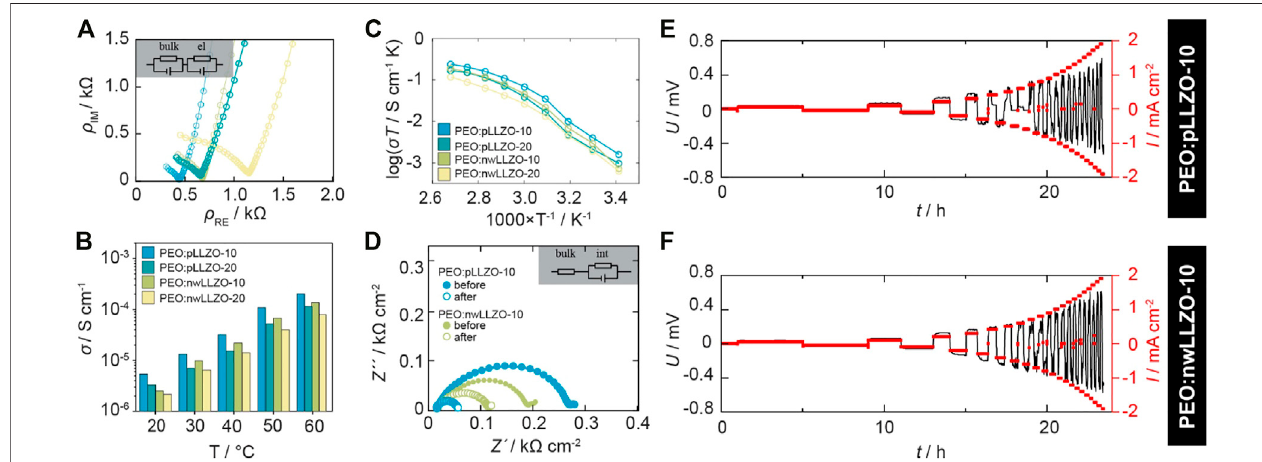
FIGURE 5 | (A) Nyquist plots of PEO:pLLZO-10, PEO:pLLZO-20, PEO:nwLLZO-10, and PEO:nwLLZO-20 at 25 ° C, and inset represents the corresponding equivalent circuit. (B) Temperature-dependent Li-ion conductivity of PEO:pLLZO-10, PEO:pLLZO-20, PEO:nwLLZO-10, and PEO:nwLLZO-20. (C) Arrhenius plots for PEO:pLLZO-10, PEO:pLLZO-20, PEO:nwLLZO-10, and PEO:nwLLZO-20. (D) Impedance spectra of PEO:pLLZO-10 and PEO:nwLLZO-10 before and after short circuitduringgalvanostaticcycling,andinsetin (D) istheequivalentcircuitadoptedforsimulation.Time-dependentcurrentandvoltagepro fi lesofLisymmetriccells consisting of (E) PEO:pLLZO-10 and (F) PEO:nwLLZO-10 at 60 ° C.